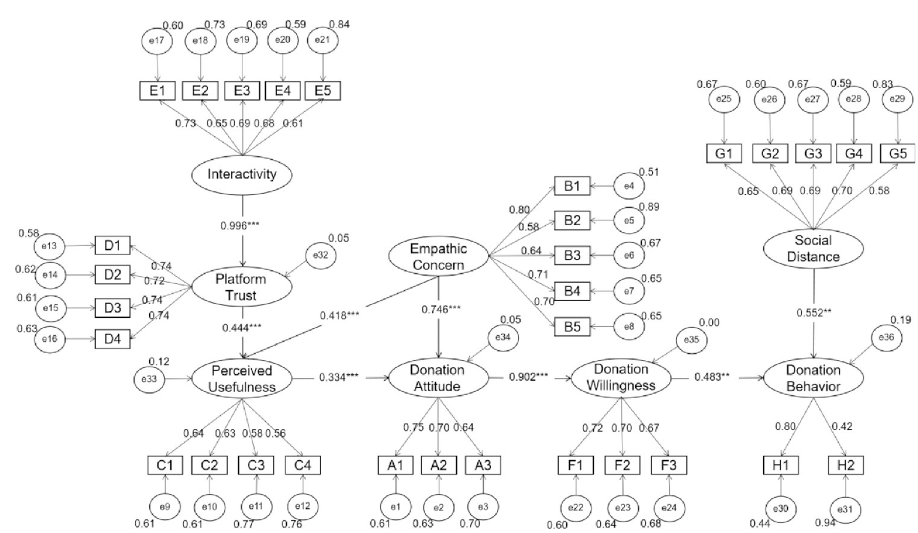
Fig 4. Path coefficients of the hypothetical model. Note: Significance levels � p < 0.05, �� p < 0.01, ��� p <